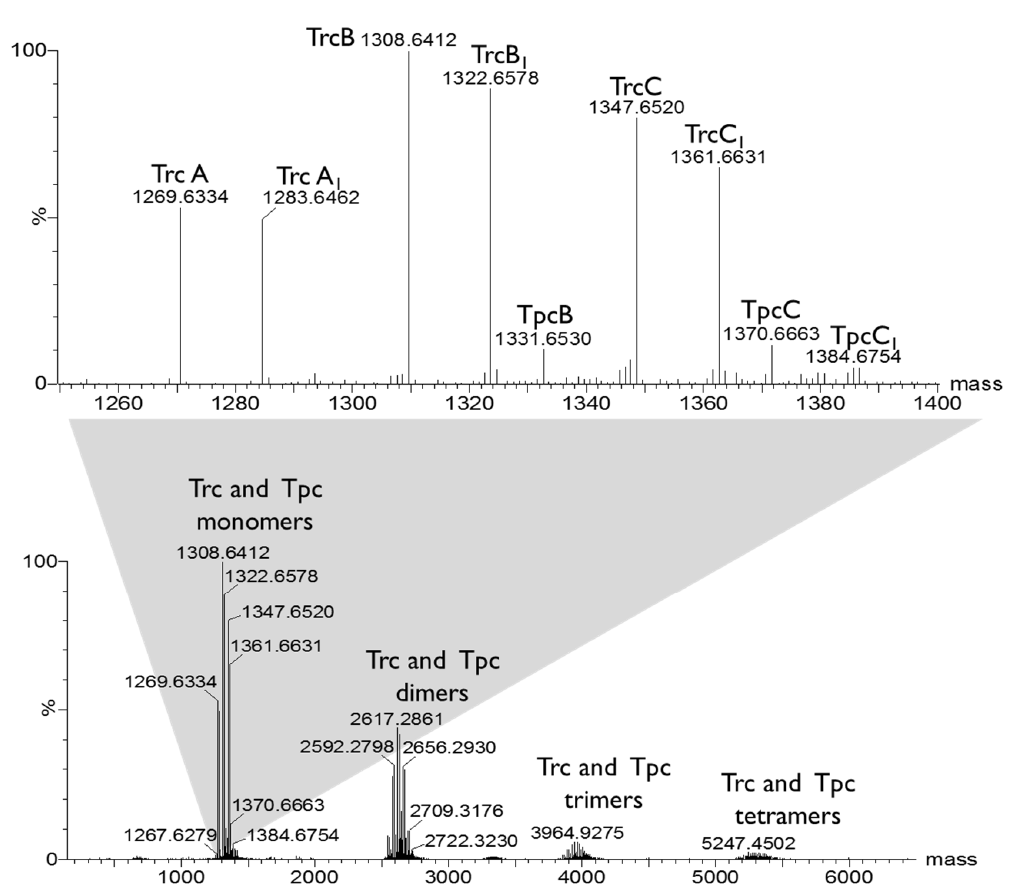
Figure 2. ESMS analysis of the cyclodecapeptides in the Trc mix. The mass spectra were generated with the MaxEnt 3 algorithm in MassLynx 4.01. The top spectrum shows the monomers in the Trc mix and the bottom spectrum shows the homo- and hetero-oligomers that were detected. Table 2. Survival (%) of 24 cultures after exposure to the Trc mix and its formulations with a vari- ety of saccharides at the three selected concentrations.